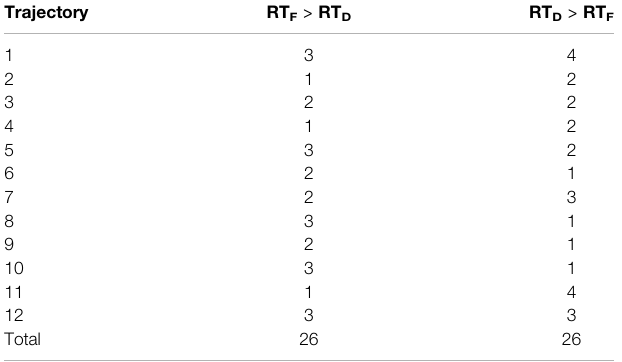
TABLE 2 | Comparison of reaction time thresholds for each direction in fl at and dynamic conditions (values below 25% and over 150% are removed, RT F is reaction time in fl at condition, and RT D is reaction time dynamic condition).